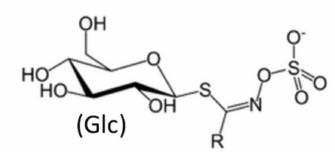
Figure 2. Glucosinolate structure. In the schematic structure of glucosinolate, R is an aliphatic, aromatic, v-methylthioalkyl, or heterocyclic residue.